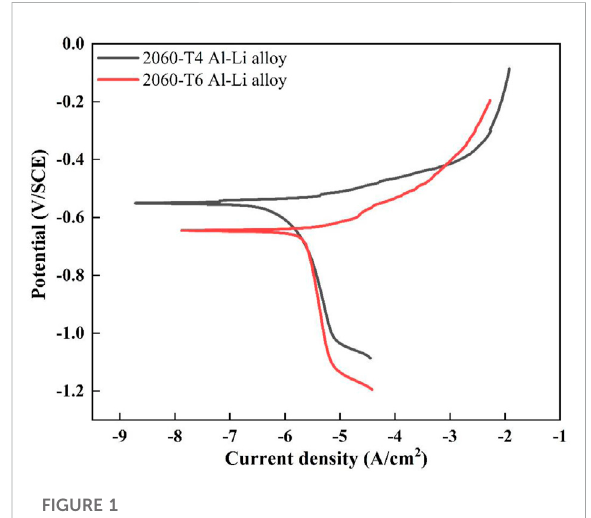
FIGURE 1 Potentiodynamic polarization curves of the 2060-T4 and 2060-T6 Al-Li alloys.